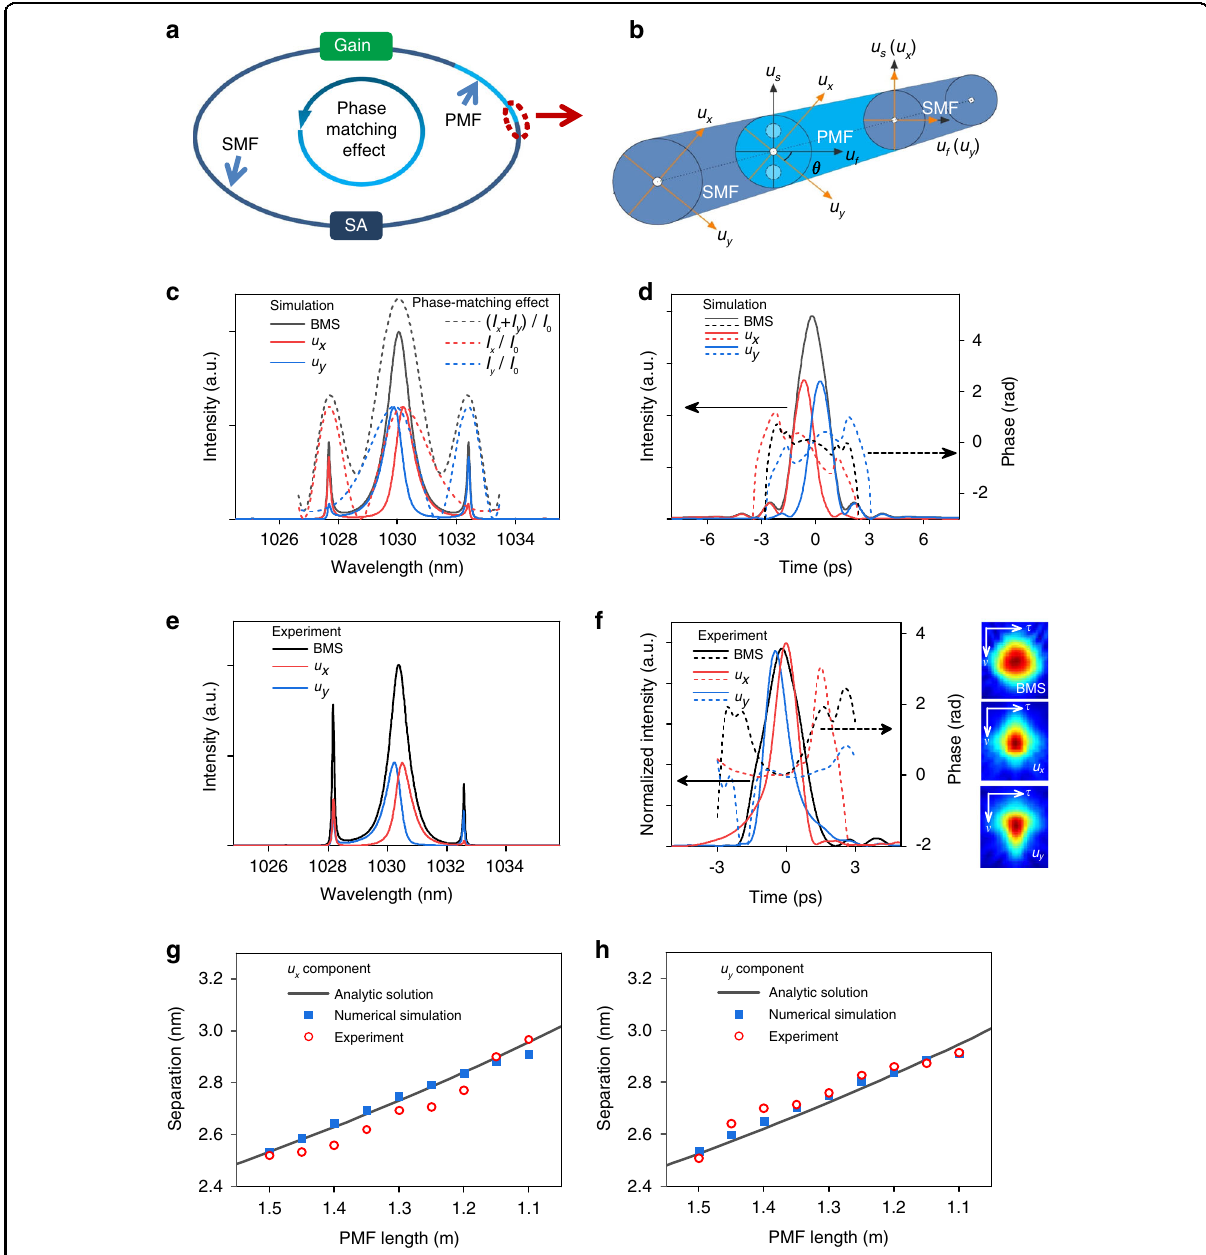
Fig. 1 Principle and simulation/experiment results of BMS in YDF lasers. a Schematic diagram of normal-dispersion fi ber lasers. b Coupling behavior of pulse from SMF to PMF. c Simulated BMS spectrum and principle of phase-matching effect. d Temporal pro fi le and phase. e Measured spectra. f Retrieved temporal pro fi le and phase from FROG spectrogram. Evolution of sideband separations with PMF length: g u x and h u y components. SMF single-mode fi ber, PMF polarization-maintaining fi ber, SA saturable